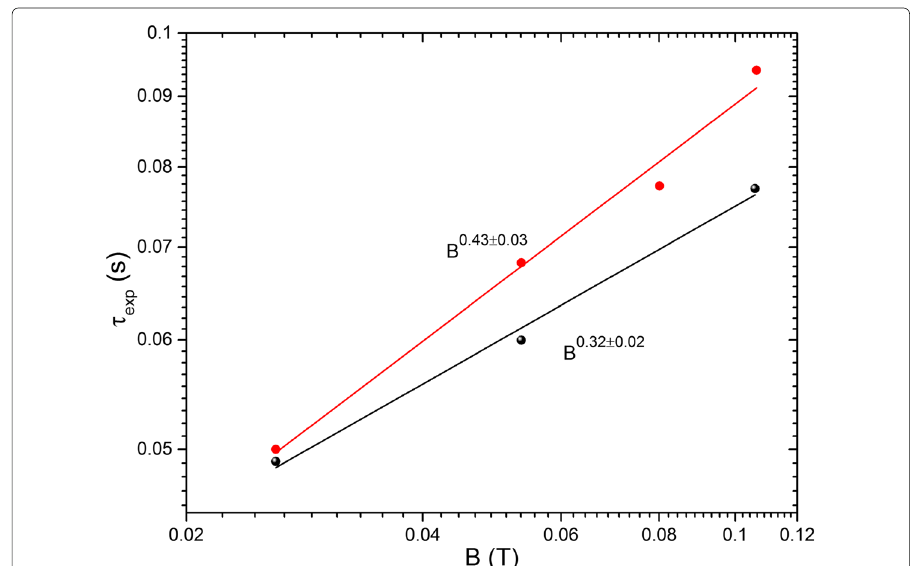
Fig. 9 Expansion time dependence on magnetic field showing the plasma expansion rate ( red ) for step up of 4V and ( black ) for step up of